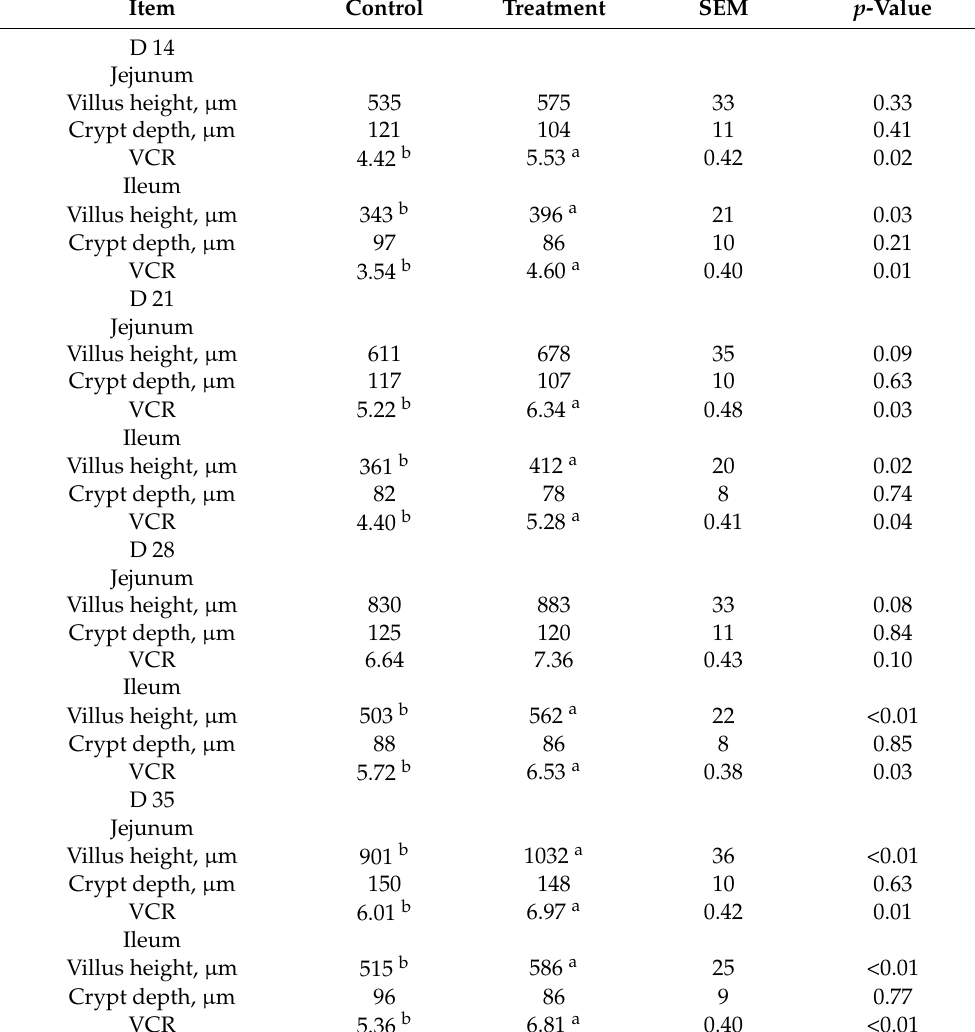
Table 5. Effects of two supplementary doses of vitamin A on intestinal morphology of young laying pullets 1